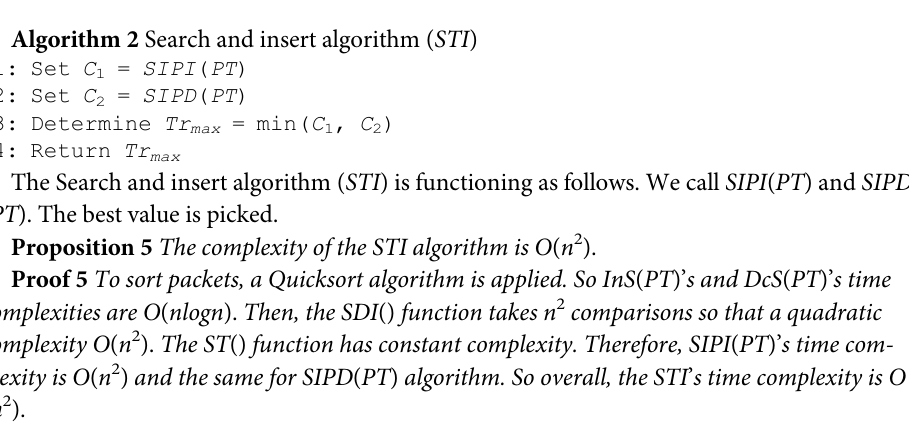
Algorithm 2 Search and insert algorithm ( STI